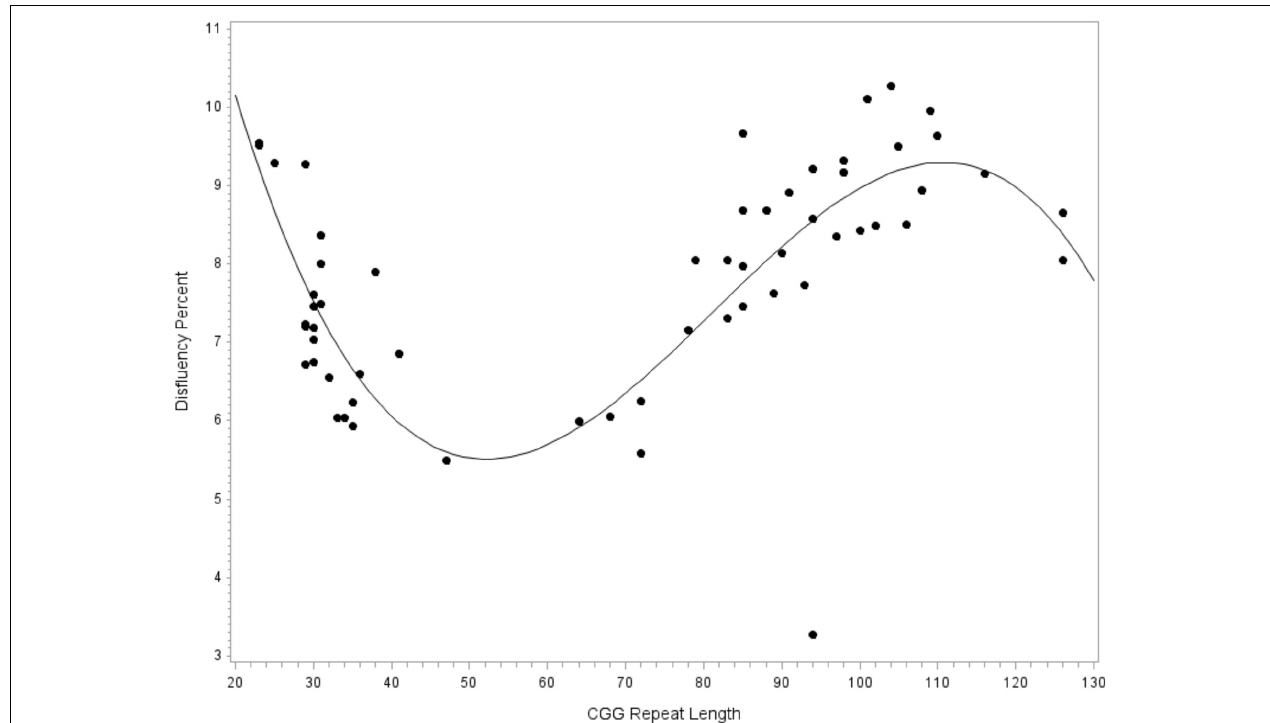
FIGURE 1 | Relationship between disfluency and CGG repeat length. Cubic association between CGG repeat length and disfluency. Model-predicted values are shown, controlling for education level, IQ, age, and allele-1 CGG